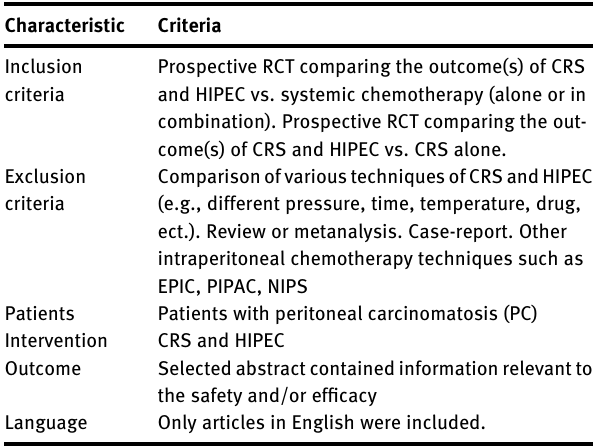
Table  : Selection criteria for relevant